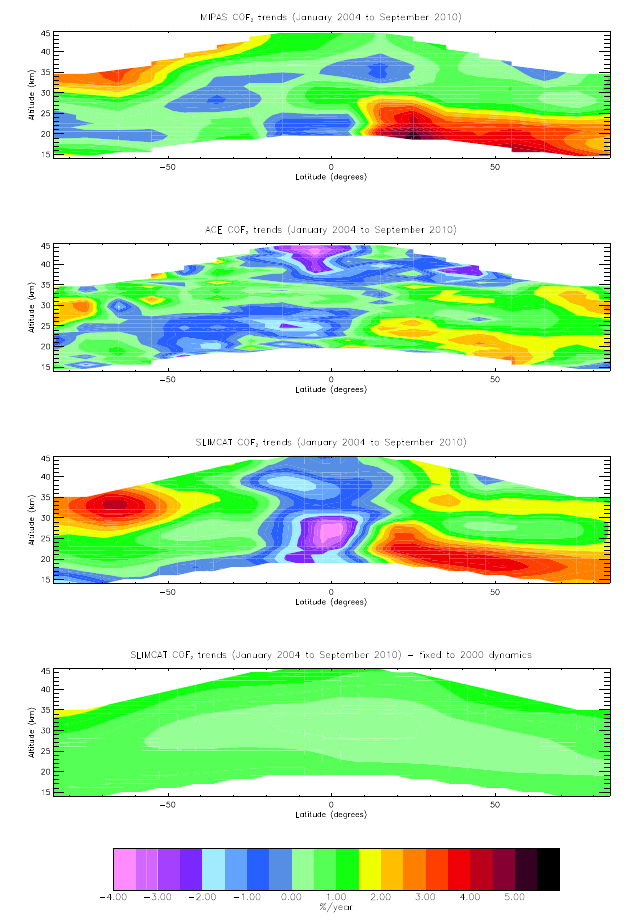
Figure 14. Annual percentage trends (January 2004 to Septem- ber 2010) for ACE, MIPAS, and SLIMCAT as a function of latitude and altitude. A full discussion of these trends is provided in the